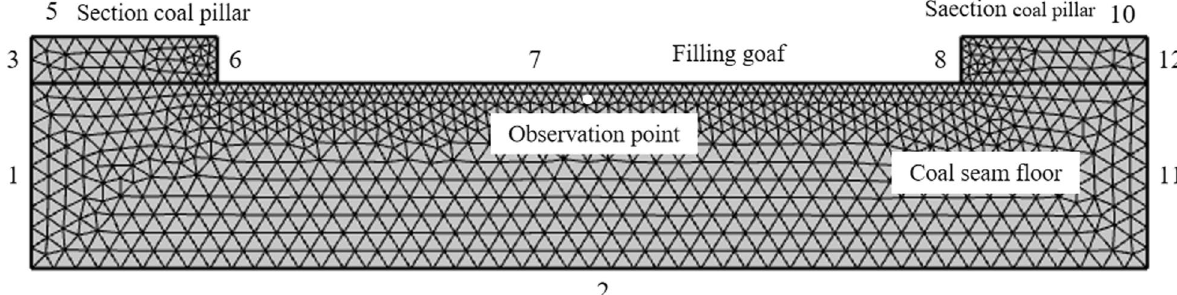
Fig. 2 Mine filling numerical subdivision